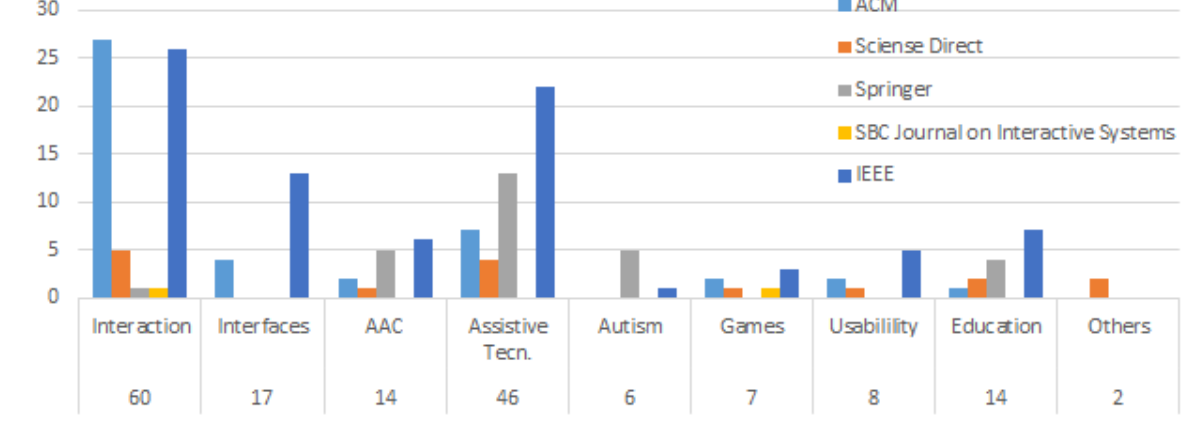
Fig. 3. Publications categorized by